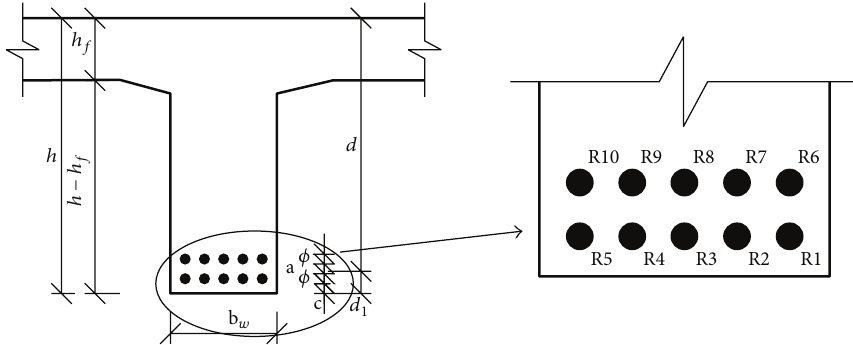
Figure 4: Bridge cross section: identified number of bars after the second diagnostics in